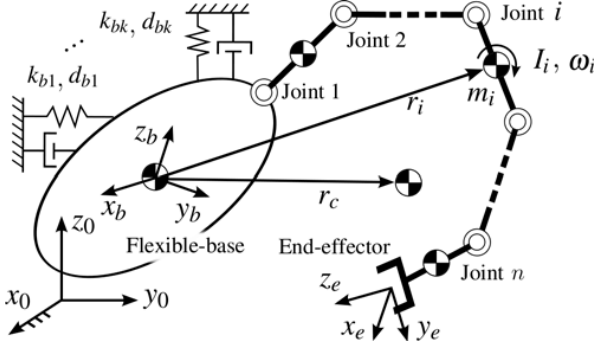
Figure 5. Model of a single-body flexible base manipulator